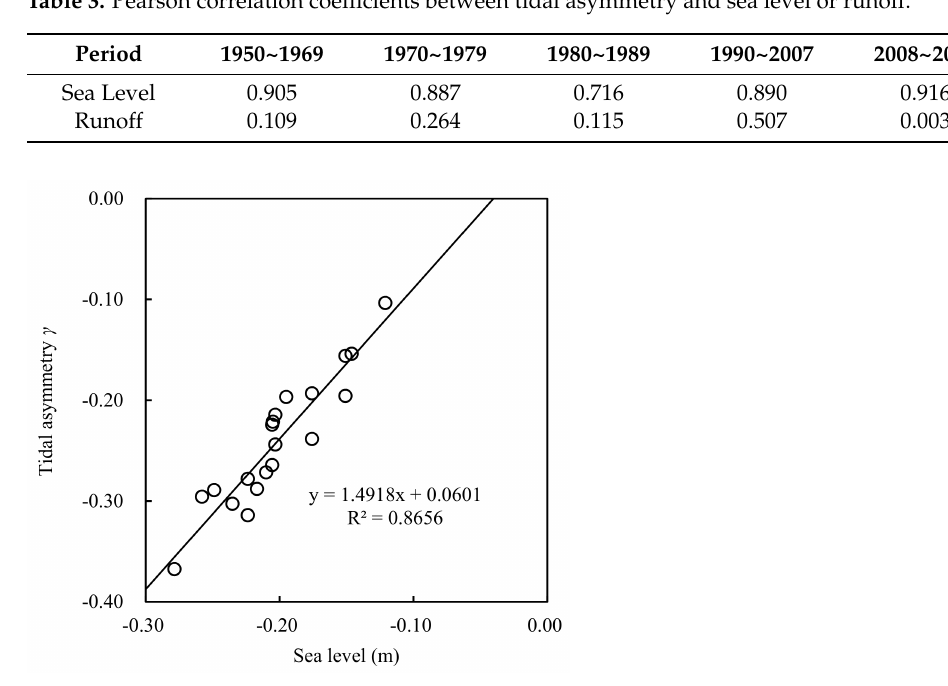
Figure 21. Tidal asymmetry and corresponding sea level, runoff and major human activities from 1950 to 2018. Table 3. Pearson correlation coefficients between tidal asymmetry and sea level or runoff.